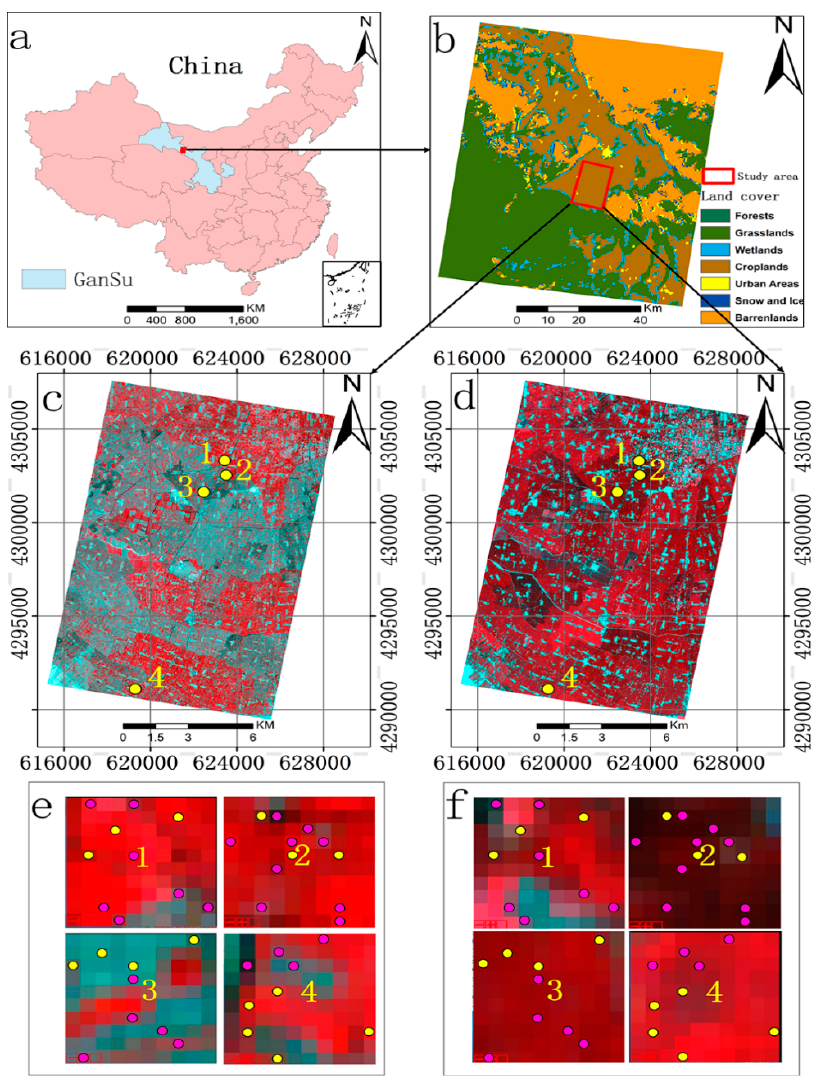
Figure 2. The study area and spatial distribution of sample plots: ( a ) The location of the study area in China; ( b ) a land cover map generated using 500 m spatial resolution MODIS MCD12 product with the study area highlighted. ( c , d ) The study area shown using a standard false color composite image from ASTER data dated on June 4th and July 10th of 2008, respectively, and the locations of 4 180 m × 180 m sample blocks. ( e , f ) Spatial distributions of the 40 15 m × 15 m sample plots within the sample blocks shown in ASTER images dated on June 4th and July 10th of 2008, respectively (50 purple plots used for developing and selecting the models and 30 yellow plots for validating the accuracy of the